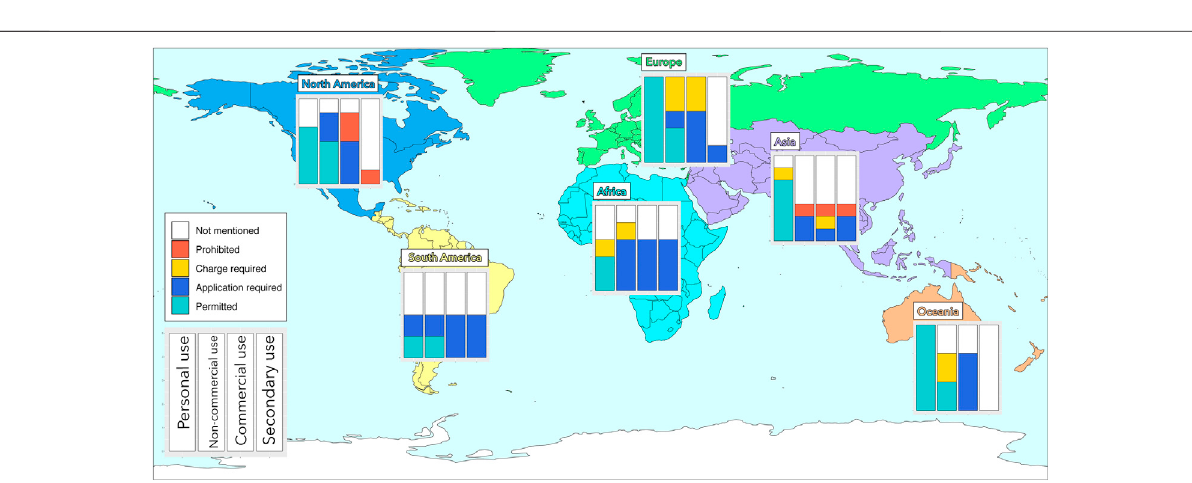
Frontiers in Earth Science |